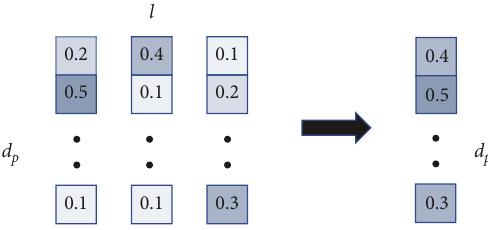
Figure 3: Schematic diagram of max-pooling